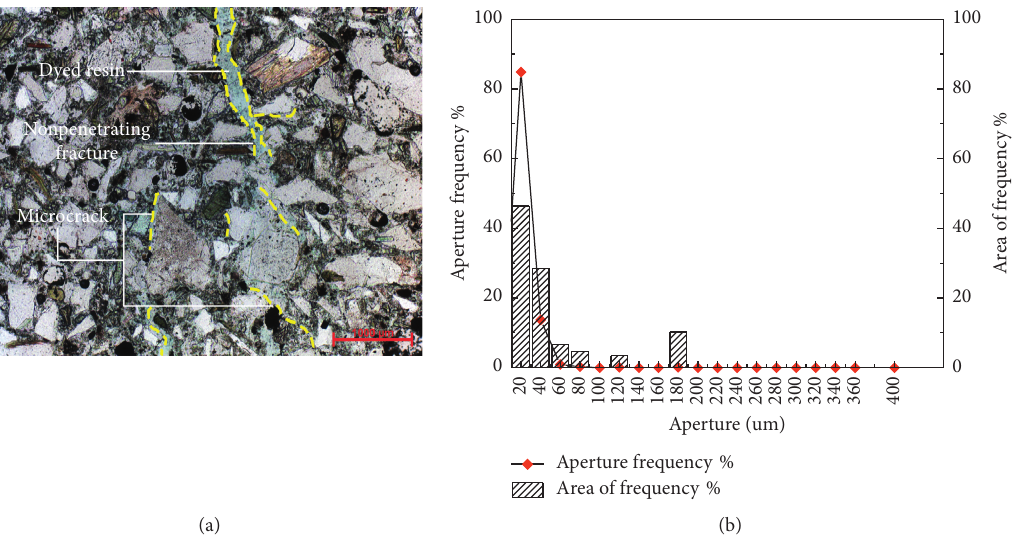
Figure 8: Plastic deformation stage of the cast thin section. (a) Slice image. (b) Pore statistical